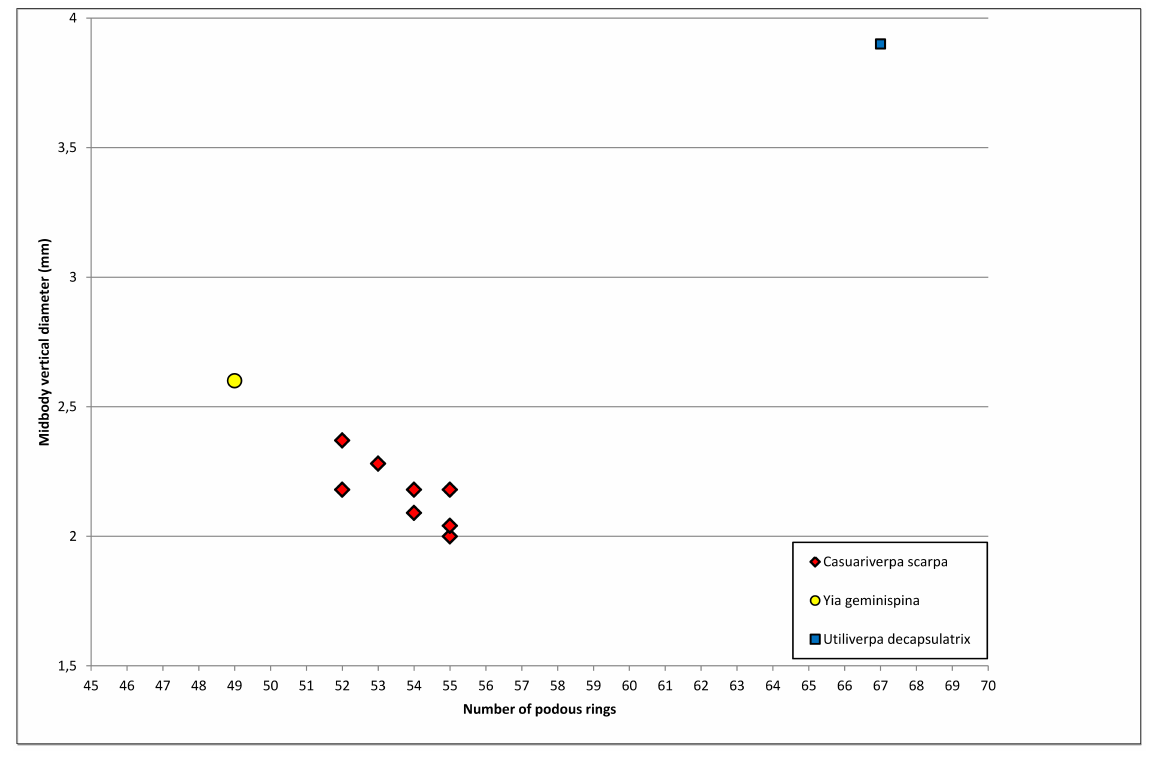
Fig. 2. Body size (body diameter/number of podous rings) of males of the new species described